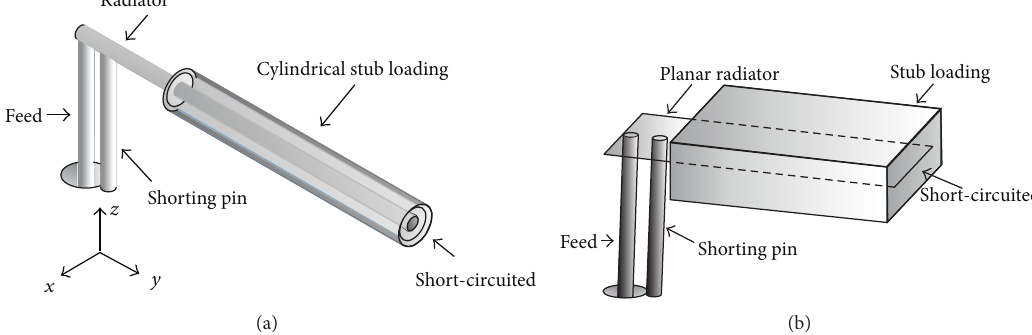
Figure 1: Proposed technique for size reduction. (a) Cylindrical stub loading for IFA and (b) waveguide stub loading for PIFA.